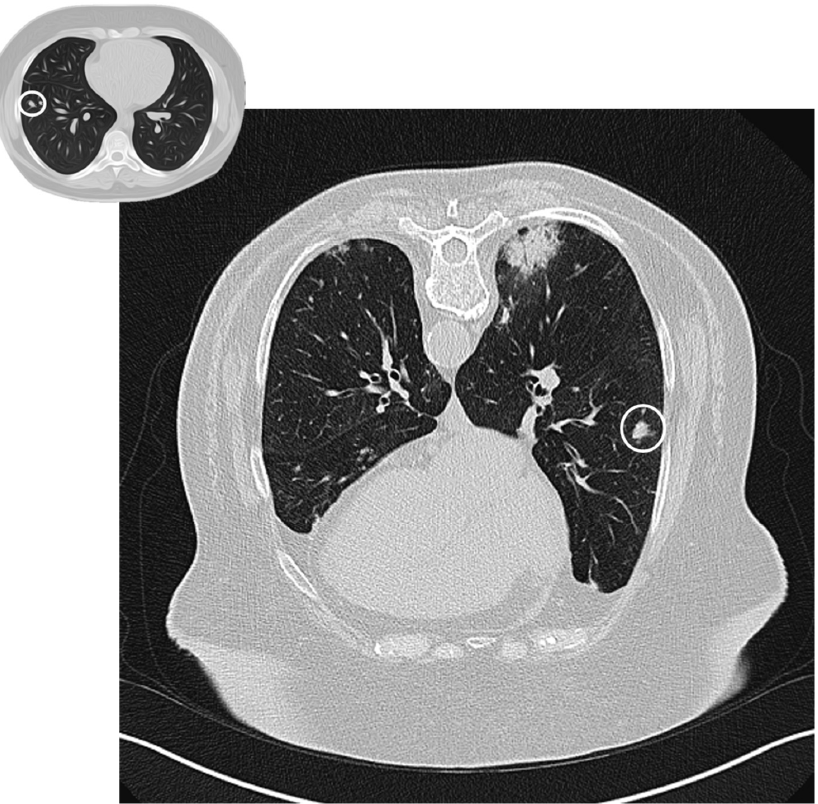
Figure 3. Nodular pattern: peripheral solid nodule (white circles) in a patient a ff ected by COP.